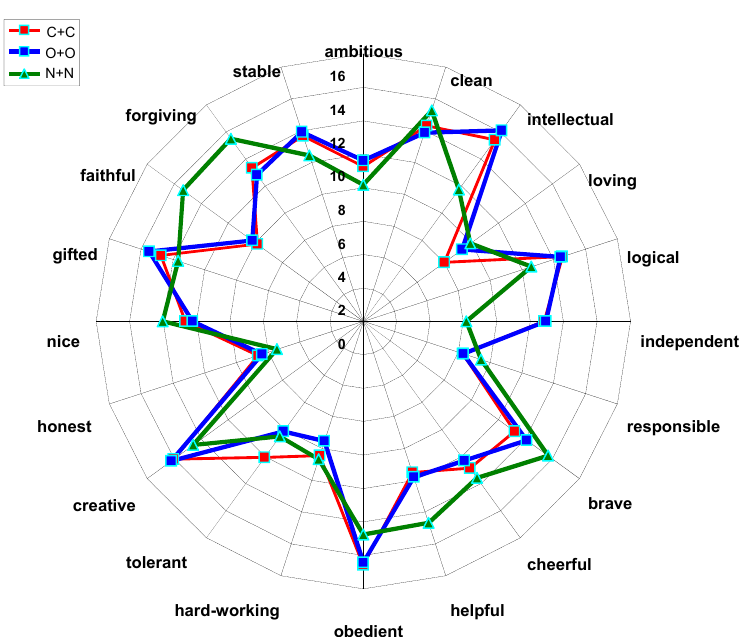
Figure 10. A list of preferences for instrumental values of Catholic and Orthodox respondents who do not declare religion. Source: own study based on research results.